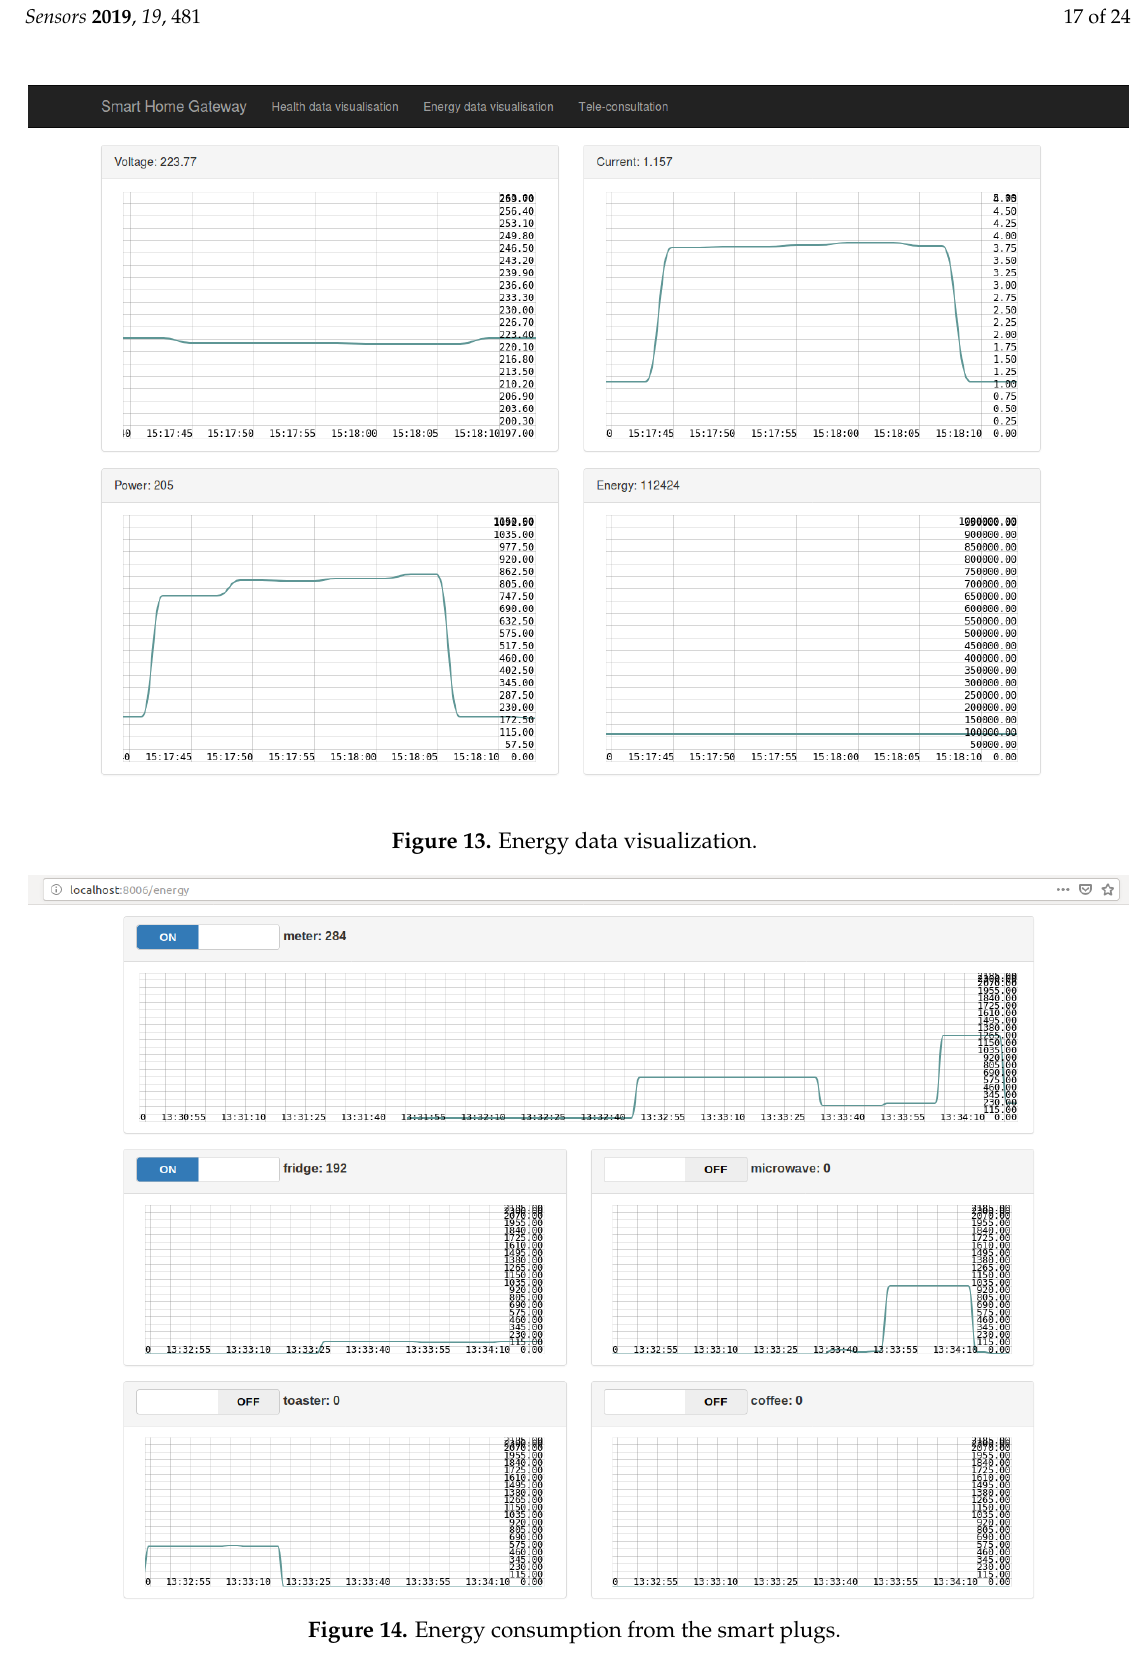
Figure 14. Energy consumption from the smart